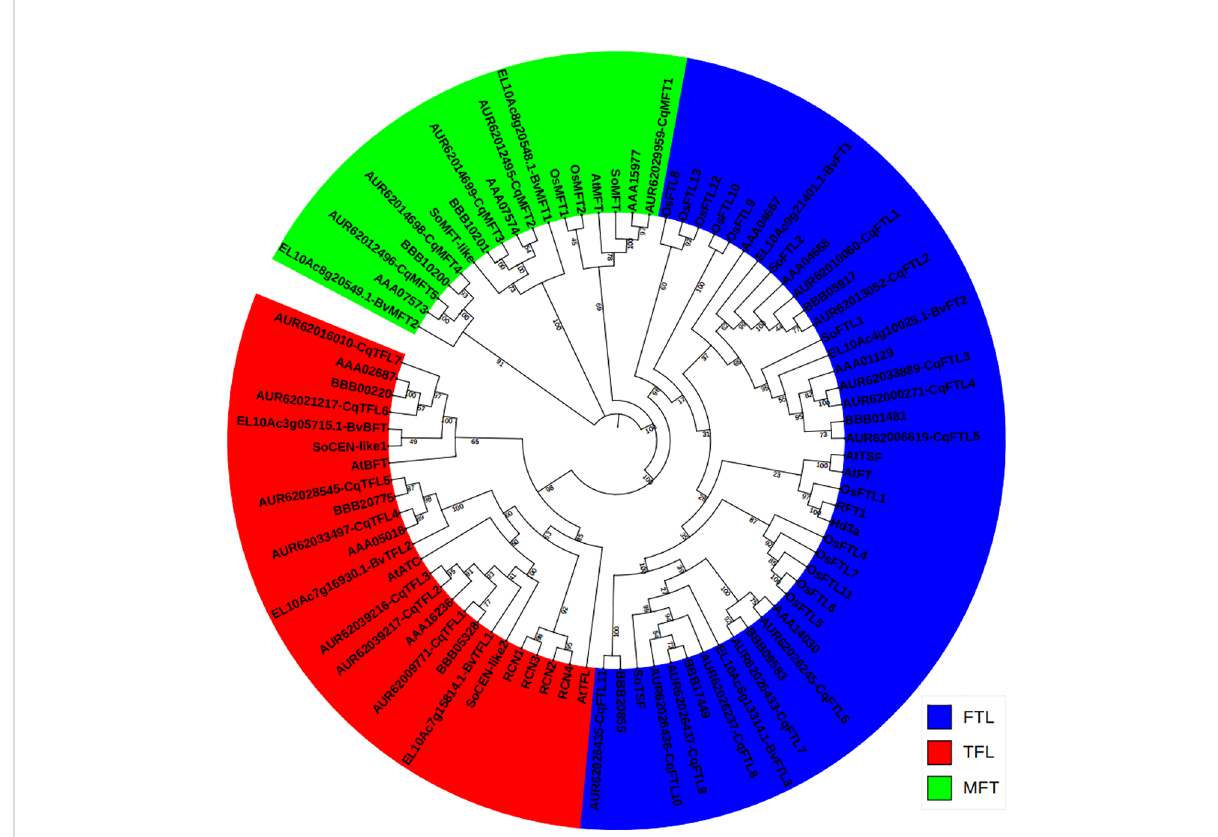
FIGURE 1 Phylogenetic relationship between the PEBP genes from Chenopodium quinoa , C. pallidicaule , C. suecicum , Beta vulgaris , Spinacia oleracea , Arabidopsis thaliana and Oryza saltiva . The PEBP protein sequences were downloaded from Phytozome V13 database. MFT , FT and TFL subclades are colored in green, blue and red, respectively. A total of 83 protein sequences were aligned using CLASTALW in MEGA 11.0. The phylogenetic tree was constructed by MEGA 11.0 using the Neighbor-Joining method with a bootstrap of 1000. The tree is unrooted, bootstrap values are indicated on